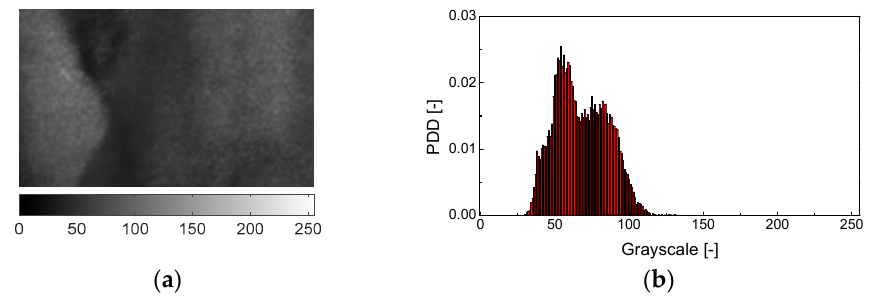
Figure 1. Original image of particle flow in gas ‐ solid fluidized bed and its grayscale histogram. ( a ) Original image. ( b ) Grayscale histogram.